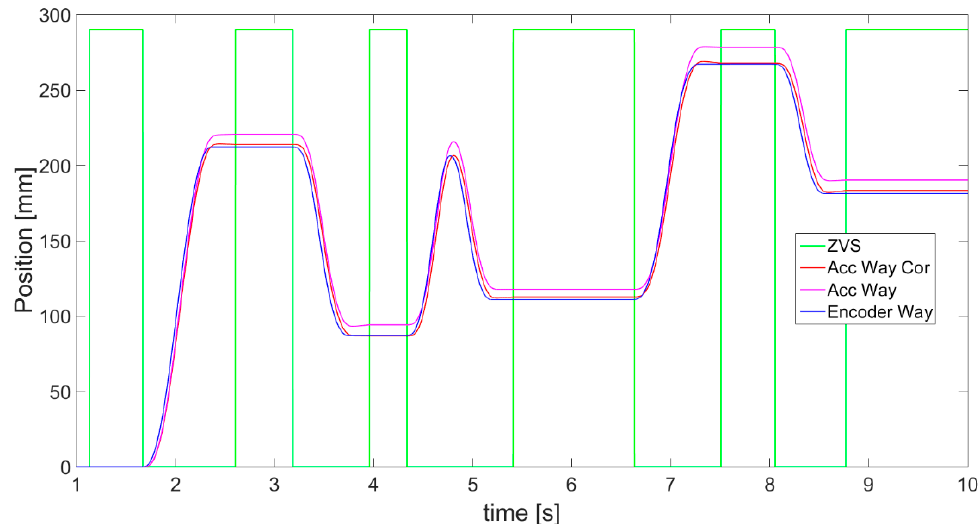
Figure 12. Comparison of displacement (way) measured from encoder (blue), estimated from acceleration after symmetrization (magenta) and calculated from the velocity’s 1st correction (red).